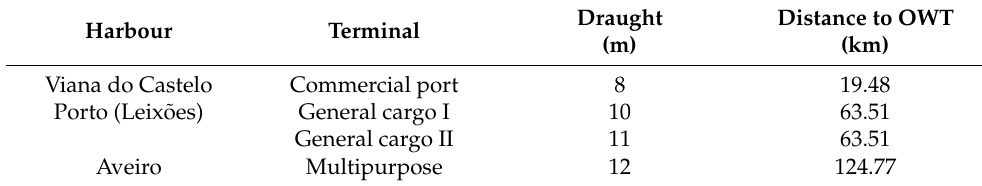
Table 4. Principal constraints of Portuguese harbours.